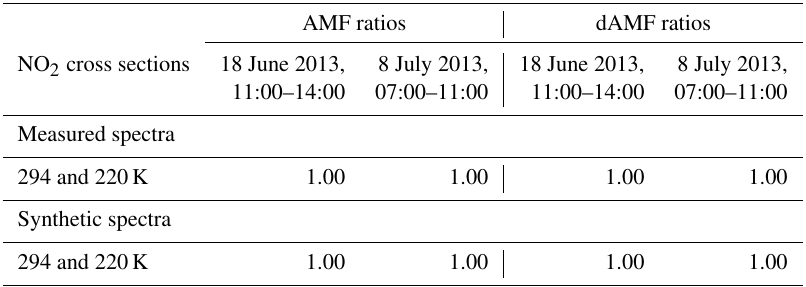
Table A18. Average ratios of O 4 (d)AMFs derived for the analysis with a second NO 2 cross section (for 220K) vs. those for the standard analysis (only NO 2 cross section for 294K) for the middle period on each selected day (top: results for spectra measured by the MPIC instrument; bottom: results for synthetic spectra when taking into account the temperature dependence of the O 4 cross